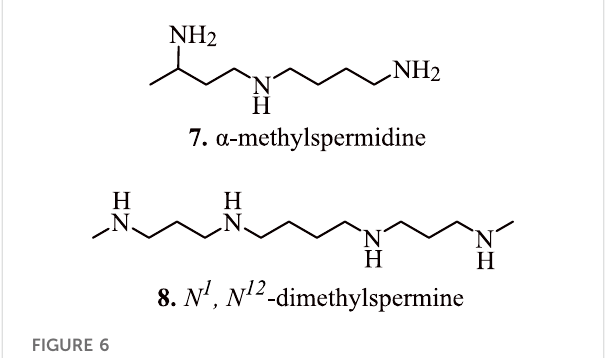
FIGURE 6 Structure of apoptosis inducing α -methylspermidine ( α -MeSpd) and N 1 , N 12 -dimethylspermine